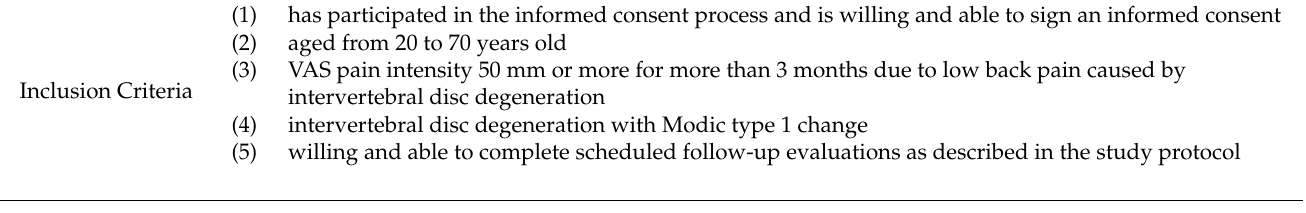
Table 1. The inclusion and exclusion